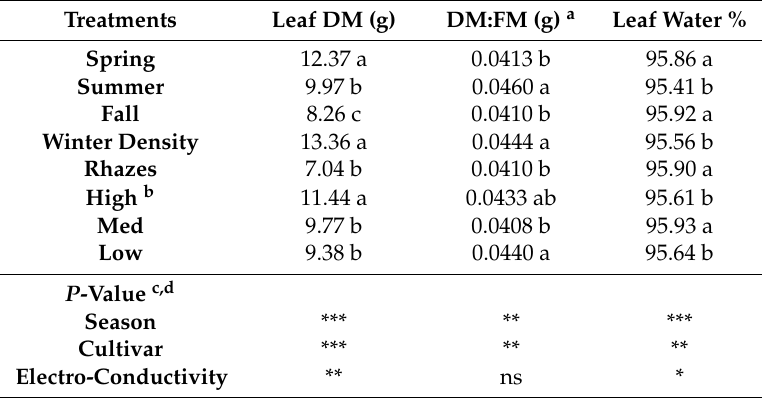
Table 1. The effect of growing season, lettuce cultivar, and EC treatment on leaf dry mass (DM) (g/plant), DM:fresh mass (FM) ratio, and lettuce leaf water content.